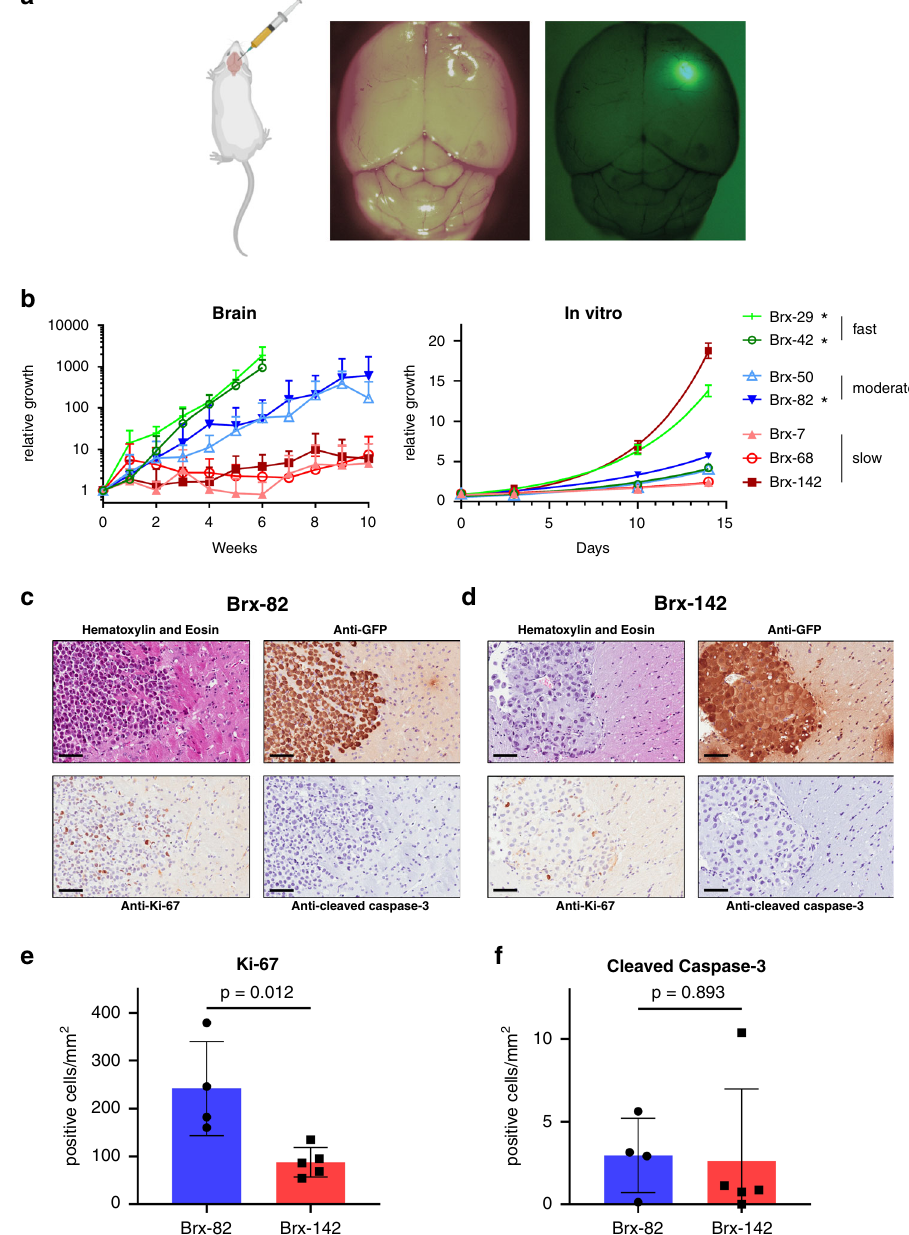
Fig. 1 Breast cancer CTC lines generate tumors after stereotactic brain injection. a CTC lines were stereotactically injected into mouse right frontal lobes. CTCs were labeled with GFP and luciferase, allowing for tumor growth monitoring via in vivo imaging and for tumor identi fi cation ex vivo. b Growth rates of CTCs after stereotactic injection into mouse brains or in vitro. CTC lines were categorized as fast, moderate, or slow growth based on their brain growth rates (in vivo: Brx-7: n = 5, Brx-29: n = 3, Brx-42: n = 8, Brx-50: n = 7, Brx-68: n = 8, Brx-82: n = 4, Brx-142: n = 6; in vitro: n = 5). Brx-29 and Brx-42 brain growth data were censored at 6 weeks due to rapid tumor growth requiring euthanasia. *CTC lines derived from patients with brain metastases. c , d Representative sections of Brx-82 ( c ) or Brx-142 ( d ) brain tumor histology after staining with hematoxylin and eosin; or with anti-GFP, anti-Ki-67, or anti-cleaved caspase 3 antibody (brown) and counter-stained with hematoxylin. Scale bars: 70 μ m. Images are representative of four tumor samples. e , f Quantitation of the number of cells positive for Ki-67 ( e ) or cleaved caspase-3 ( f ) per mm 2 by immunohistochemical staining of brain tumor histologic sections (Brx-82: n = 4; Brx-142: n = 5). P values calculated by two-tailed unpaired t -test. Data for in vitro experiments represent mean ± SD and for in vivo experiments represent mean ± SEM. Source data are provided as a Source Data fi